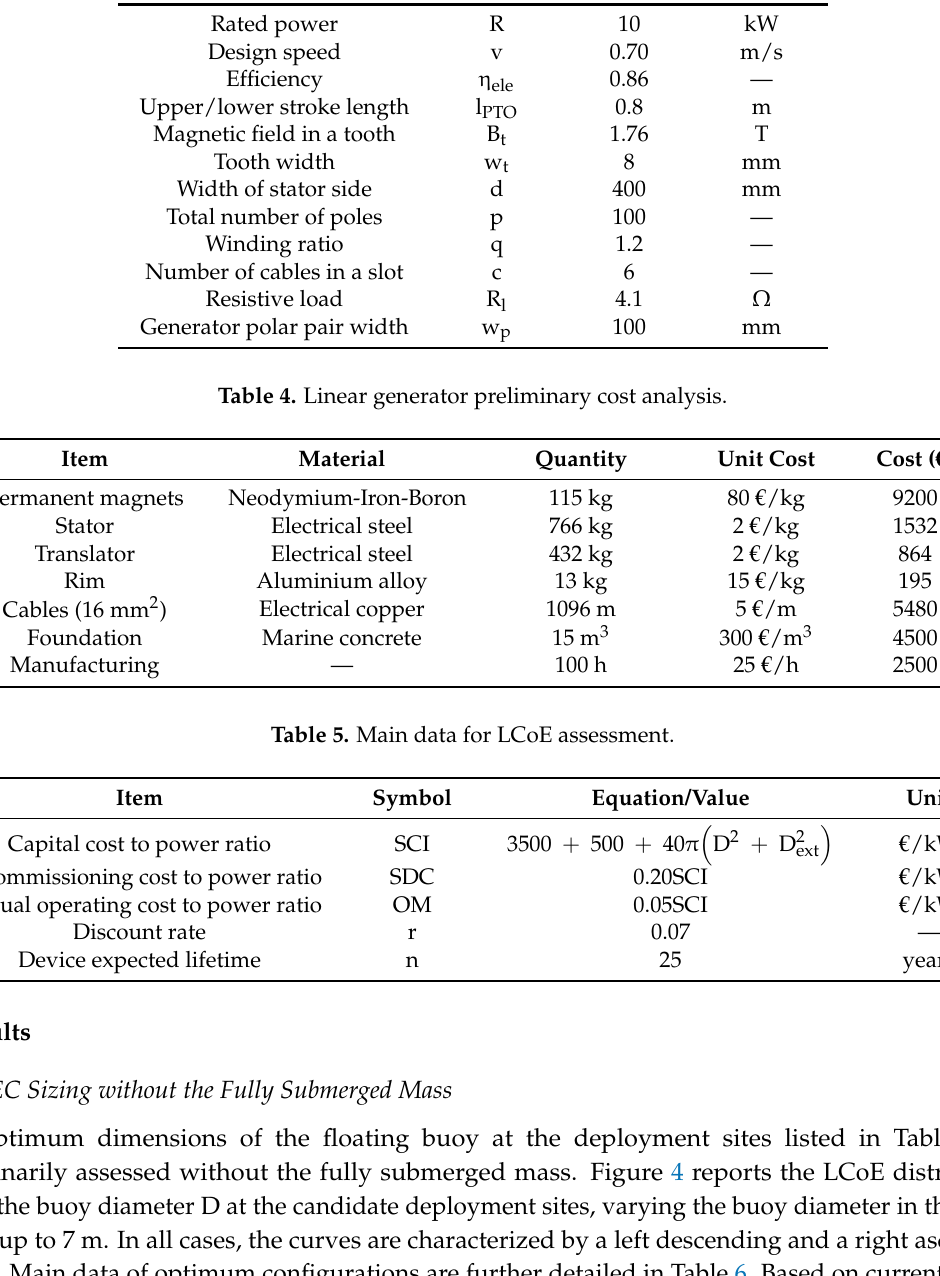
Table 3. Linear generator main data.